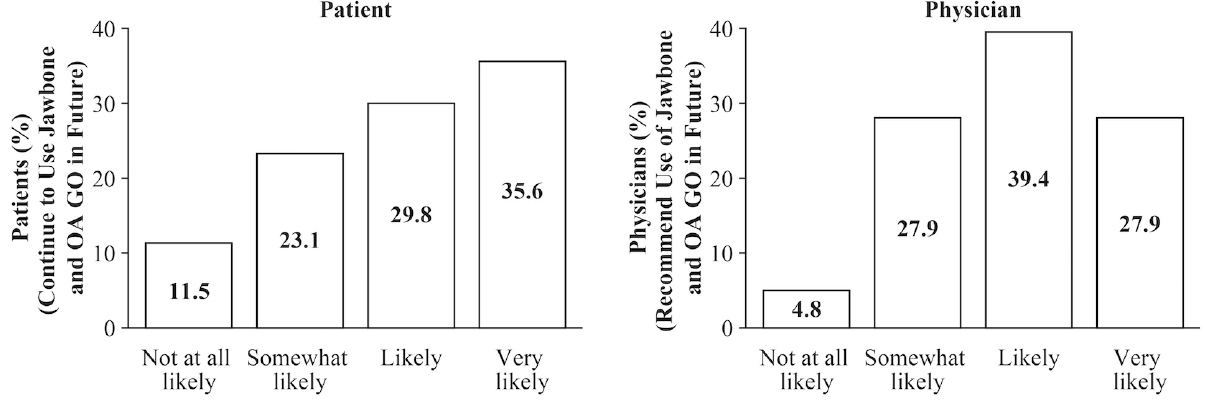
Figure 5. Satisfaction survey results in patients and physicians. Only patients in Group A (n=104) and their associated physicians participated in the satisfaction survey, which was completed at day